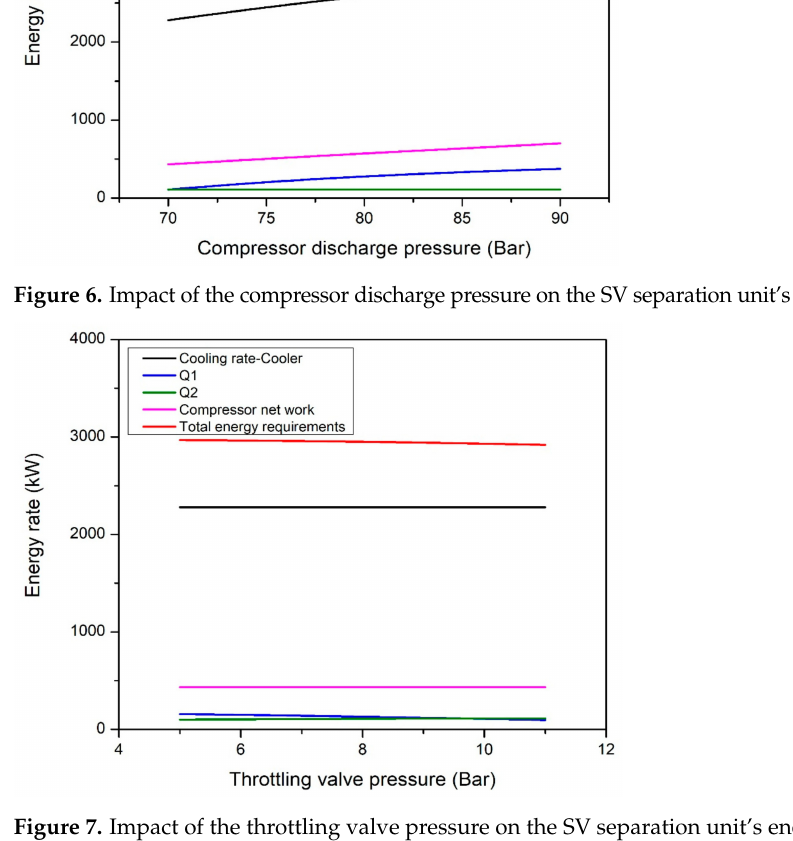
Figure 7. Impact of the throttling valve pressure on the SV separation unit’s energy